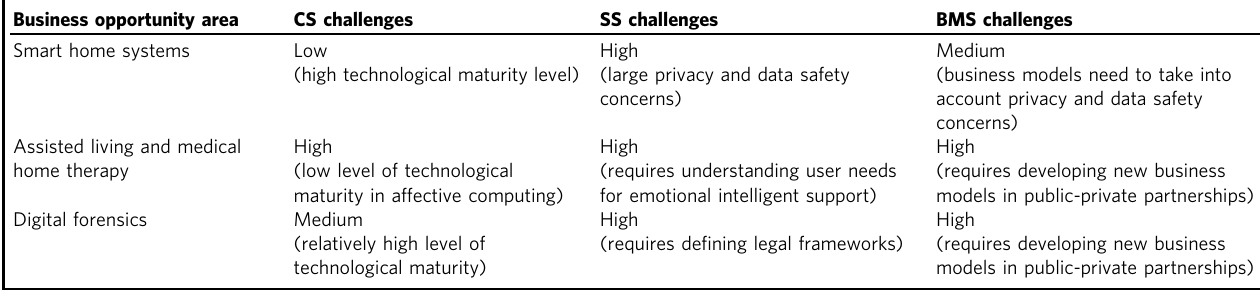
Table 7 Overview of VA business opportunity areas and disciplinary